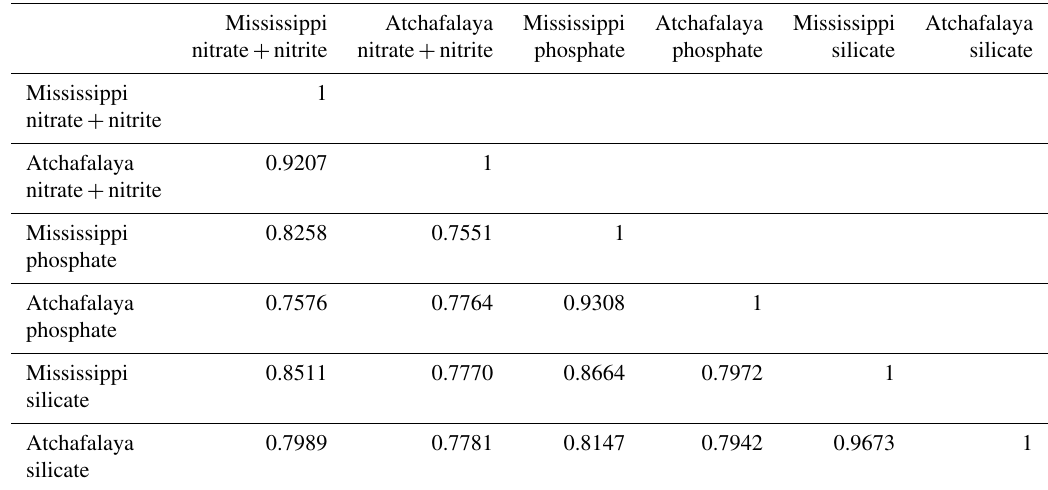
Table A1. A correlation matrix of monthly mean inorganic nutrient loads by the Mississippi River and the Atchafalaya River from 2007 to 2020. Correlation coefficients shown are all significant ( p< 0 .